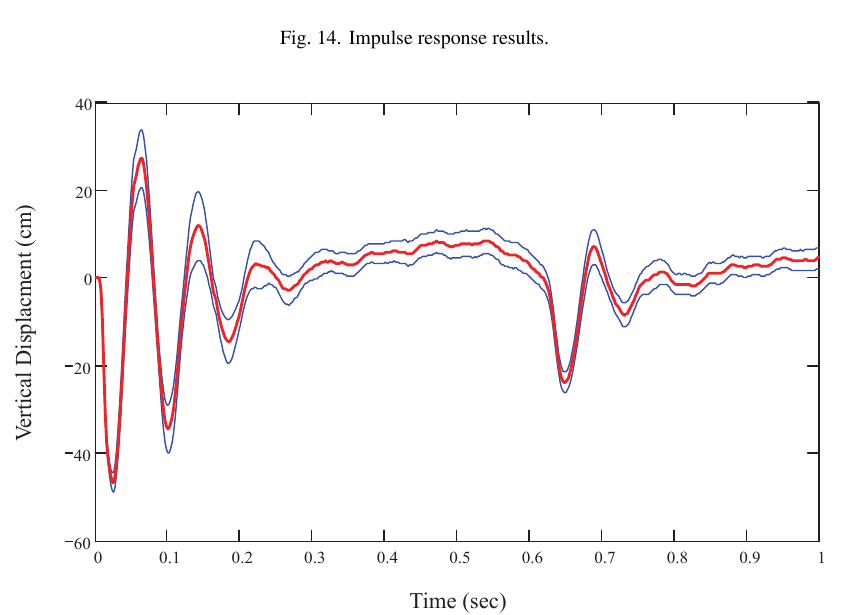
Fig. 14. Impulse response results.